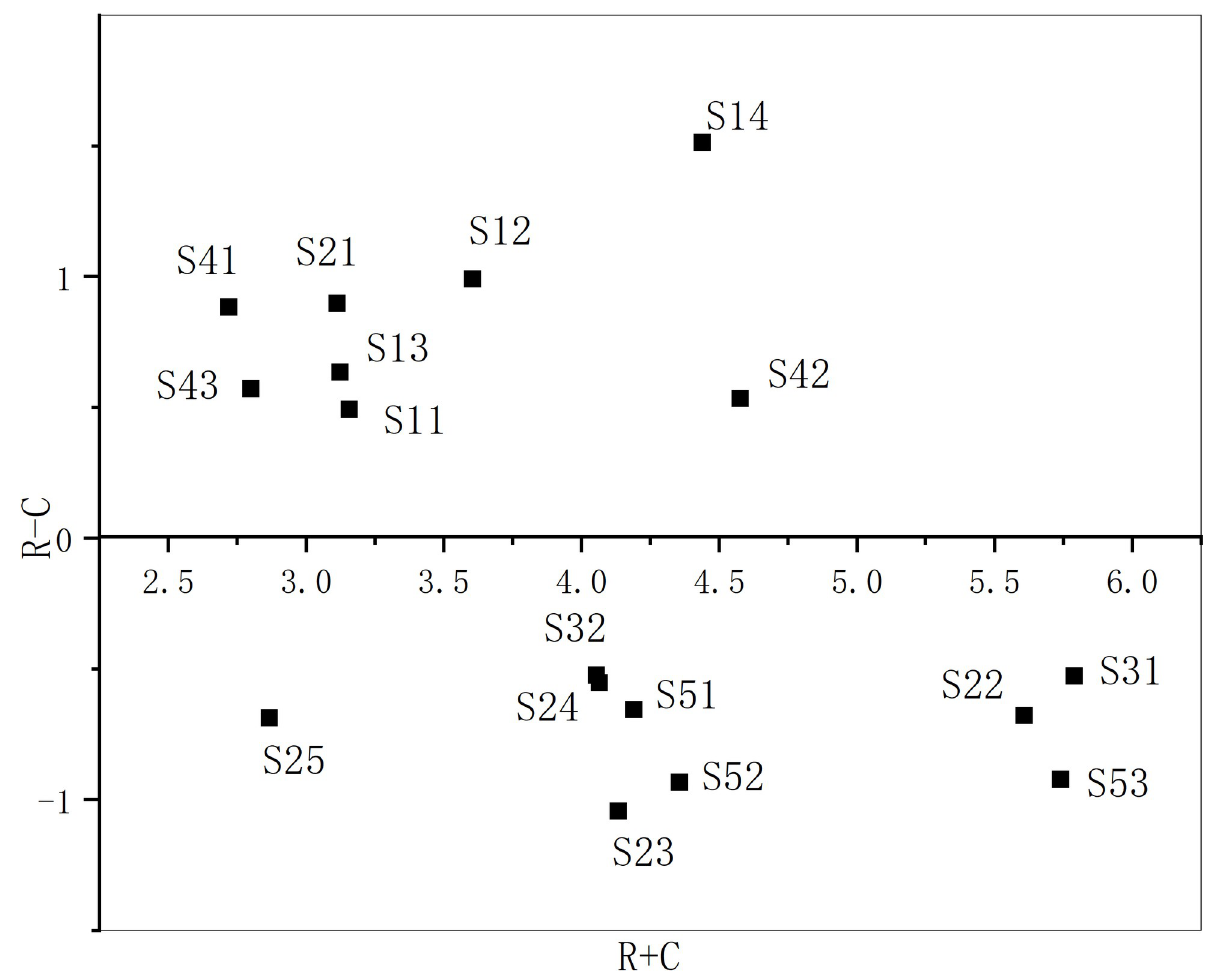
Fig 2. The Cartesian coordinate system of R+C and